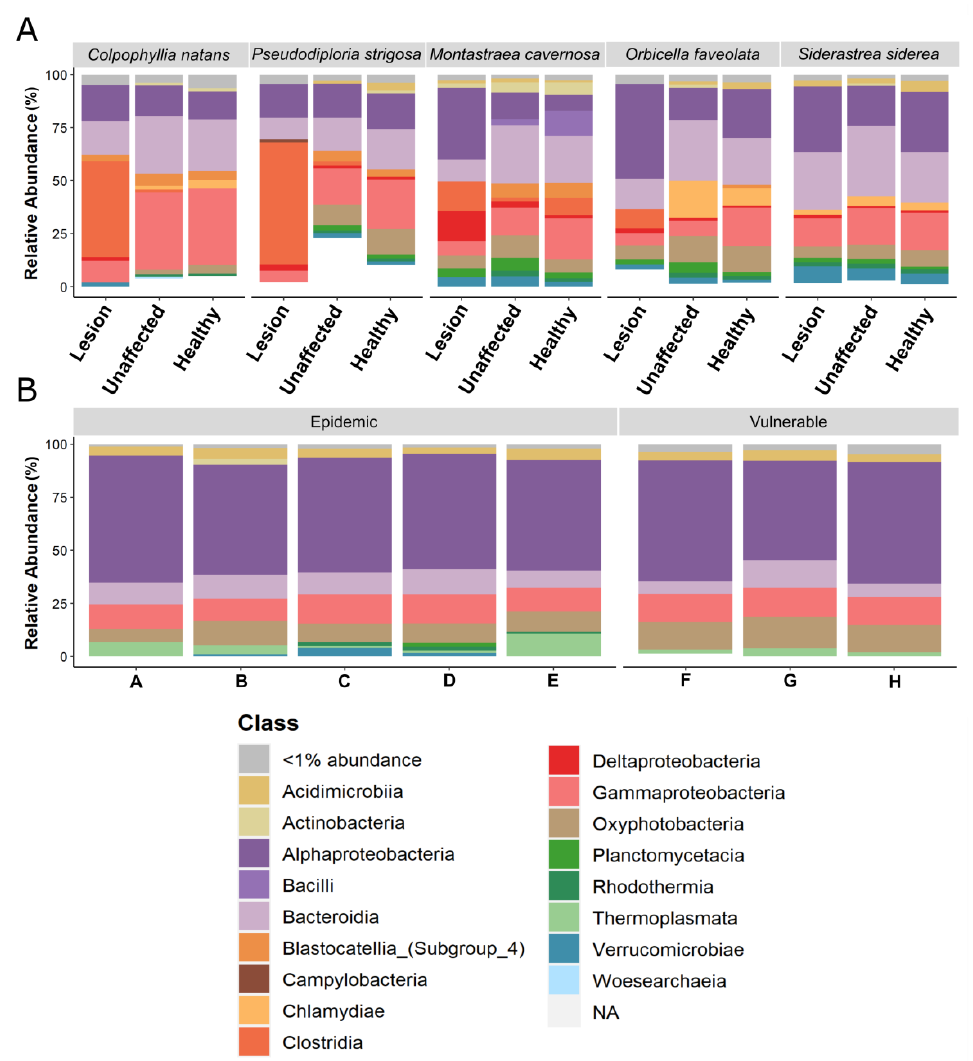
Figure 7. Mean relative abundances of amplicon sequence variants (ASVs) visualized at the bacterial class level in ( A ) lesion and unaffected tissues from colonies with stony coral tissue loss disease, and tissue of apparently healthy colonies, collected from Colpophyllia natans , Pseudodiploria strigosa , Montastraea cavernosa , Orbicella faveolata , and Siderastrea siderea in the epidemic zone. Additionally, shown are the mean relative abundances of bacterial classes in ( B ) water samples collected across the epidemic zone (Sites A–E) and vulnerable zone (Sites F–H). Displayed are taxa with ≥ 100 ASV counts in at least 10% of samples. Taxa with < 100 ASV counts are represented by the white space. Among the moderately susceptible species, Alphaproteobacteria was generally more dominant in DL tissues. Alphaproteobacteria was the dominant member (31.08%) of DL tissue of M. cavernosa even though they were also present, albeit at lower abundances (<13.86%), in AH and DU tissues. These two tissue sample types of M. cavernosa had relatively high levels of Bacteroidia (19.02% and 23.28%, respectively) compared to DL tissue (10.49%). In all three O. faveolata tissue sample types, Alphaproteobacteria,